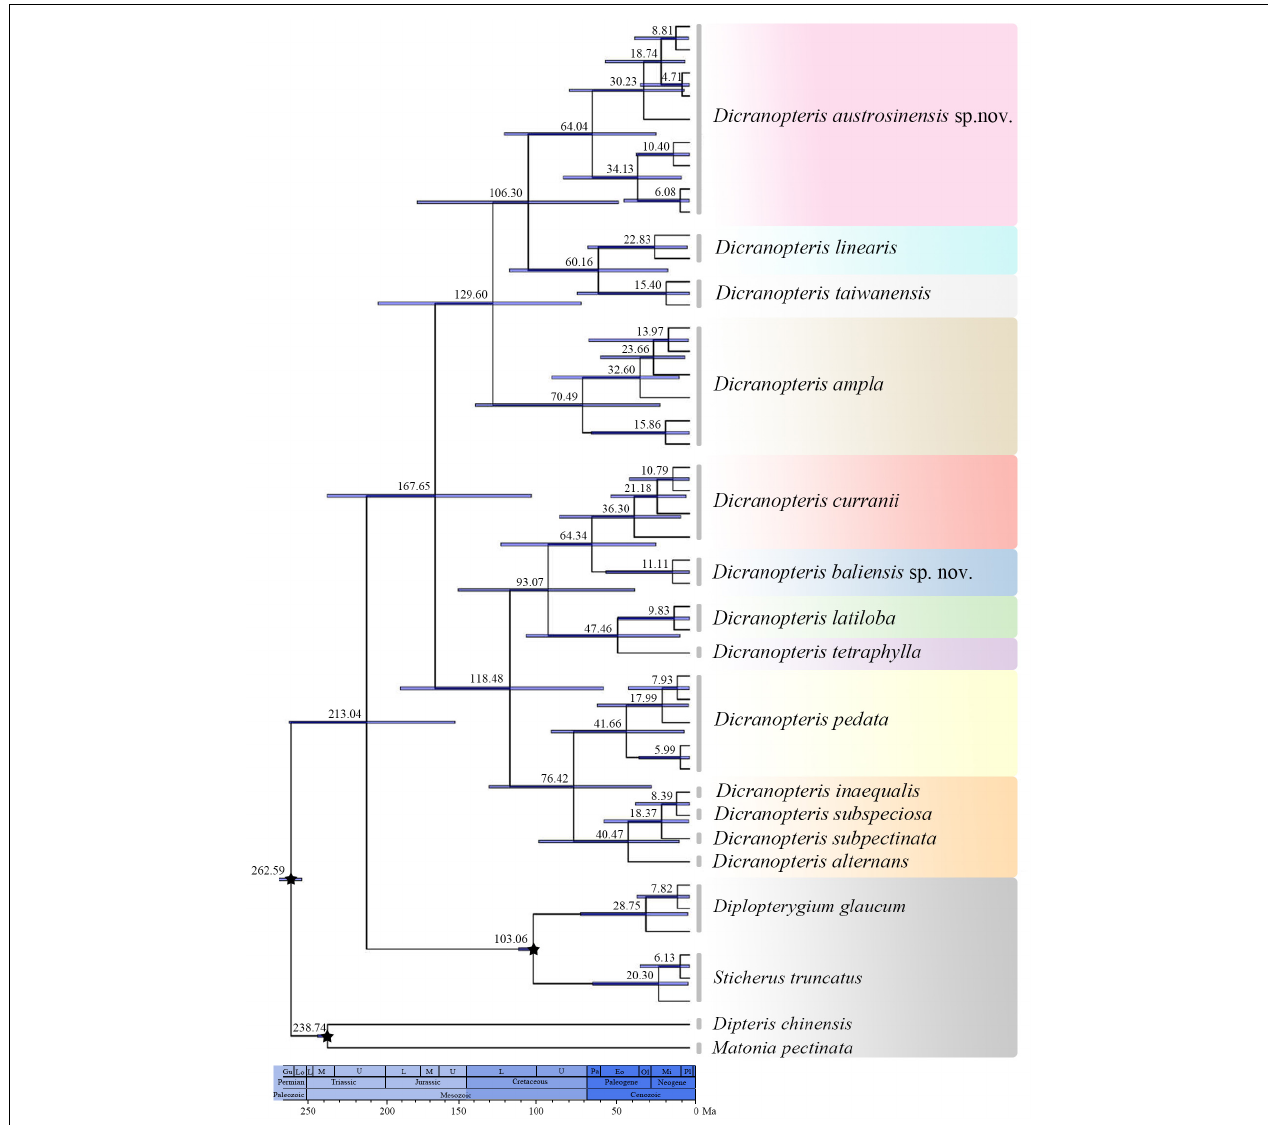
FIGURE 3 | Chronogram presenting estimated divergence times using BEAST based on the concatenated rbcL , atpB , rps4 , trnL-trnF , and matK dataset. Numbers above/under the tree branches represented median ages and 95% highest posterior density (HPD) intervals. Break stars indicated the calibrating